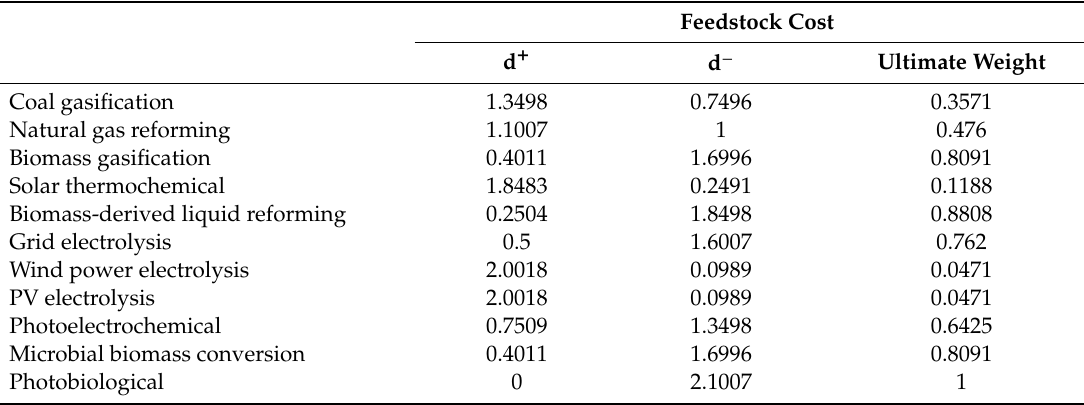
Table A3. Distance from FPIS and FNIS, and ultimate weights of feedstock cost.